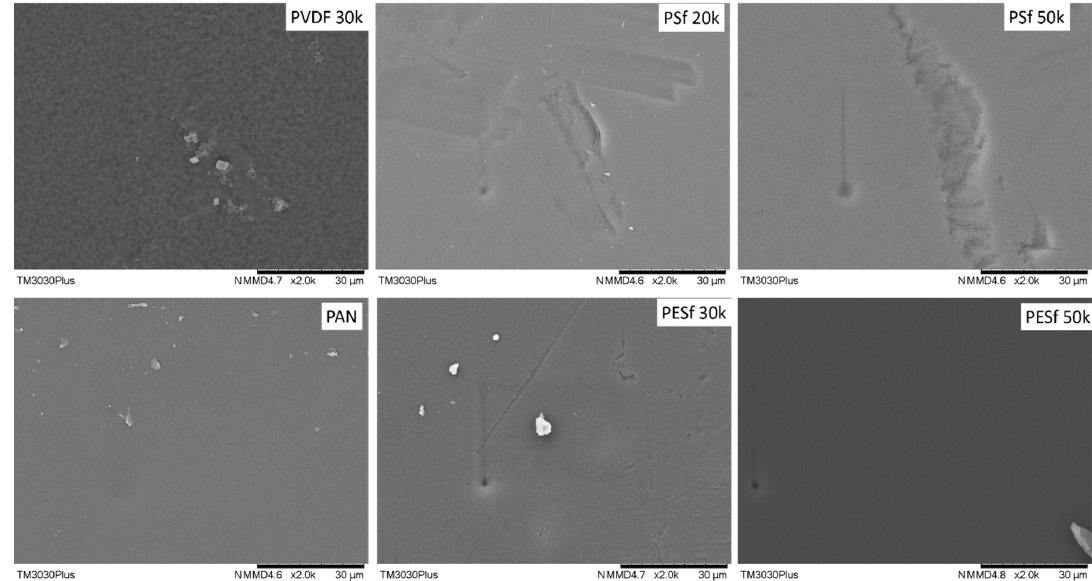
Figure 2. Surface morphology of the 6 porous supports selected—unwashed.